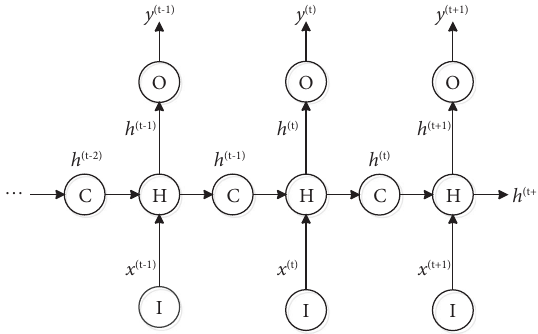
Figure 4: Unfolding the Elman neural network architecture through time. Figure 5: Architecture of LSTM